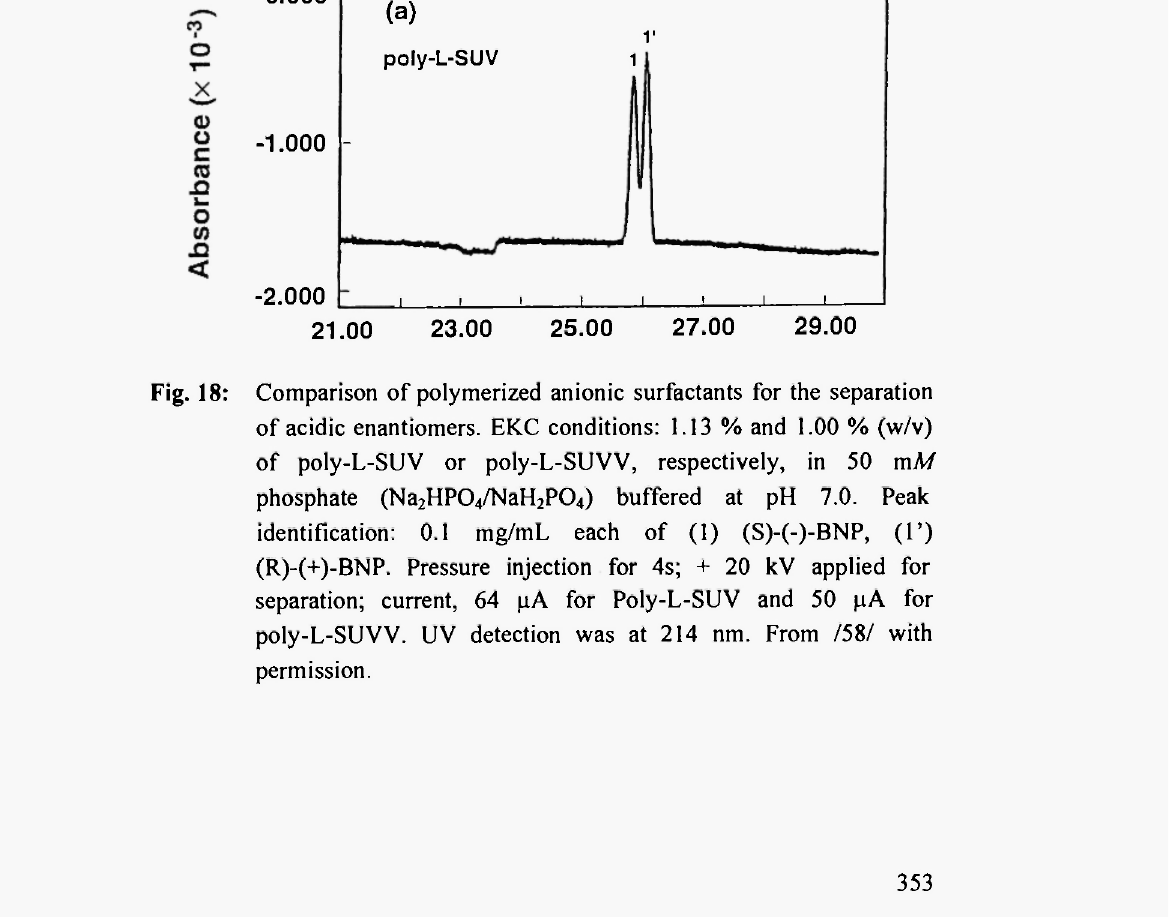
Fig. 18: Comparison of polymerized anionic surfactants for the separation of acidic enantiomers. EKC conditions: 1.13 % and 1.00 % (w/v) of poly-L-SUV or poly-L-SUVV, respectively,